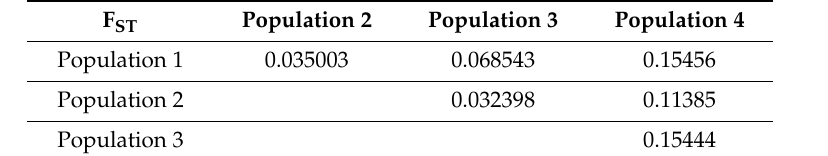
Table 3. F-statistics among 51 sampling locations distributed in the southern regions of China. (The color coding of populations corresponds to Figure 2 (K = 4); red represents population 1, green represents population 2, blue represents population 3, and purple represents population 4.).